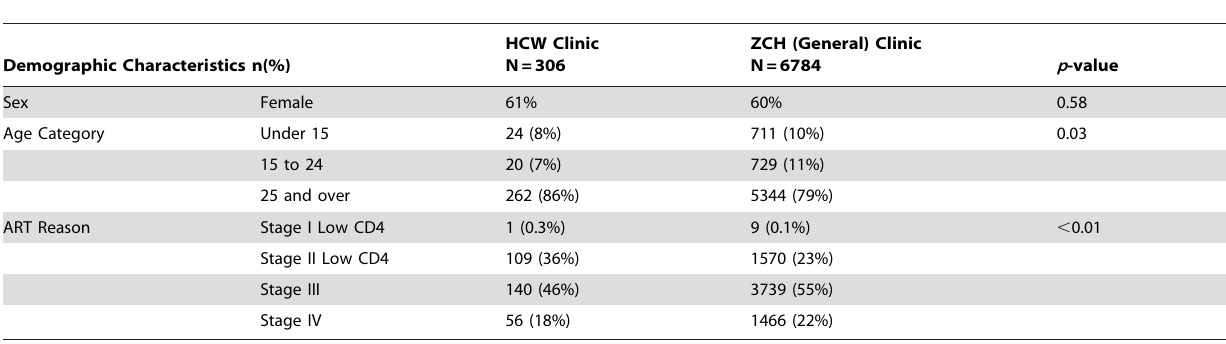
Table 1. Demographic characteristic of ART patients initiated in HCW clinic vs. general clinic.